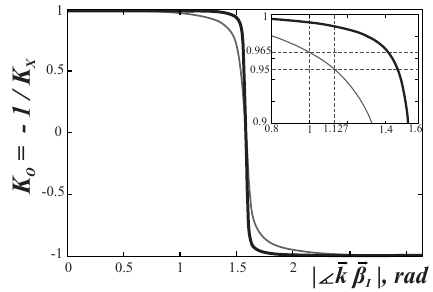
Fig. 1. Ellipticity coefficient for normal modes in the angular range 0 (cid:20) ̸ j ⃗k ⃗B I j (cid:20) π at the frequencies 23.7 MHz (thin line) and 111 MHz (thick